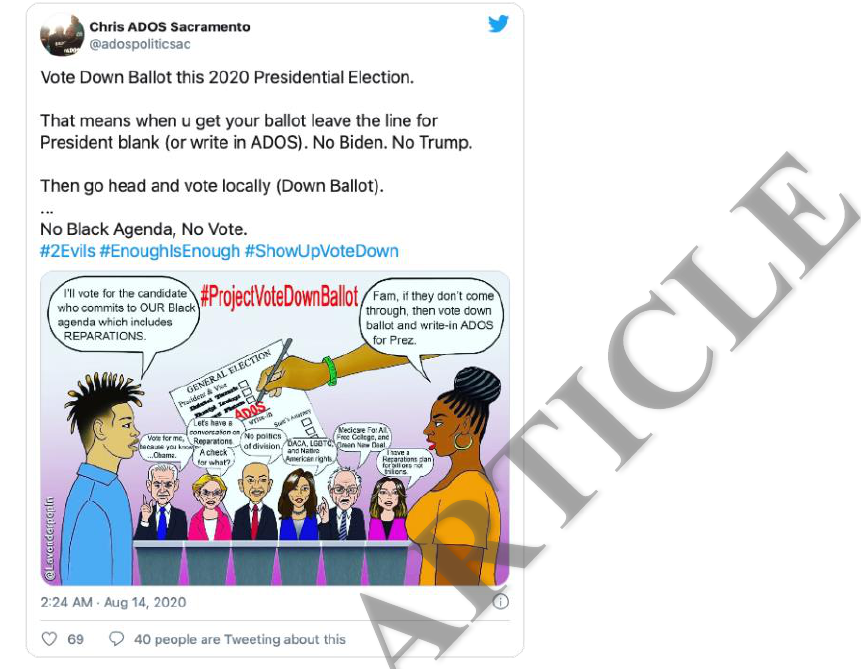
Figure 4. A tweet of ADOS content, containing a content summarizing the ADOS worldview and election strategy,